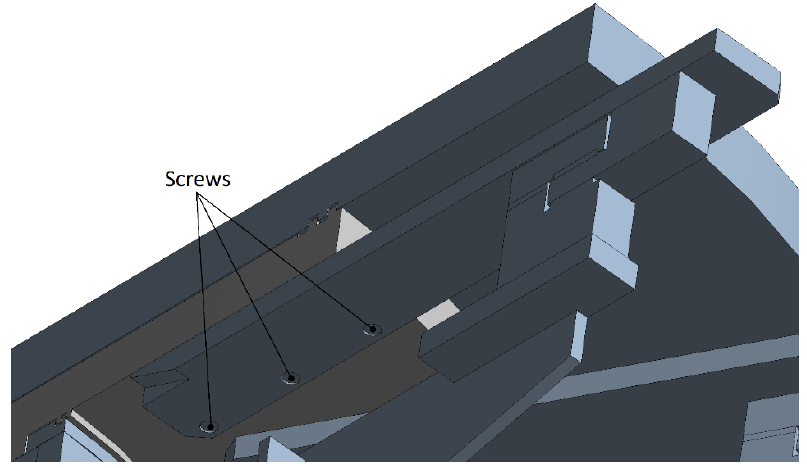
Figure 15. Bolted connection between the support and the rotary table of the Transfer Machine with 15